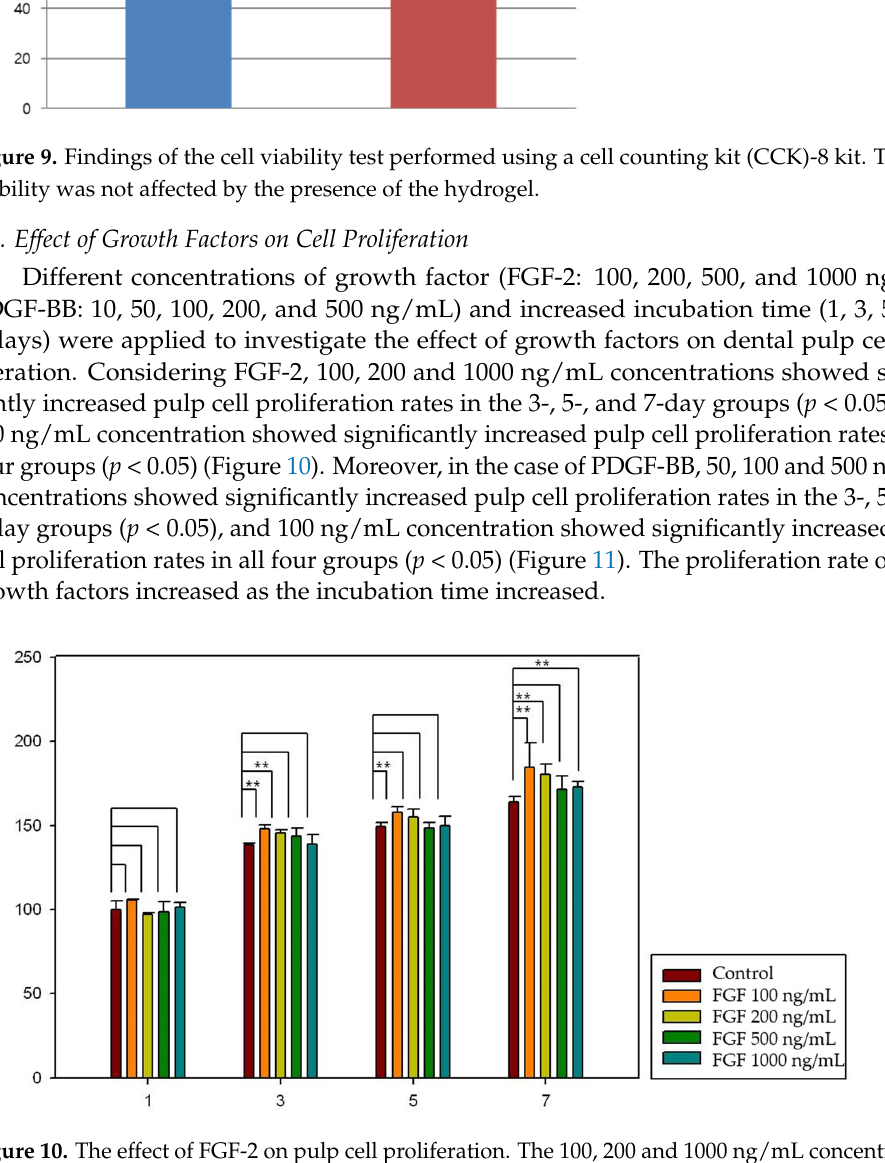
Figure 10. The effect of FGF-2 on pulp cell proliferation. The 100, 200 and 1000 ng/mL concentrations showed significantly increased pulp cell proliferation rates in the 3-, 5-, and 7-day groups ( p < 0.05). The 100 ng/mL concentration showed significantly increased pulp cell proliferation rates in all four groups ( p < 0.05). The results are expressed as mean values ± standard deviation. ** indicates the statistically significant differences ( p < 0.05). FGF, fibroblast growth factor.